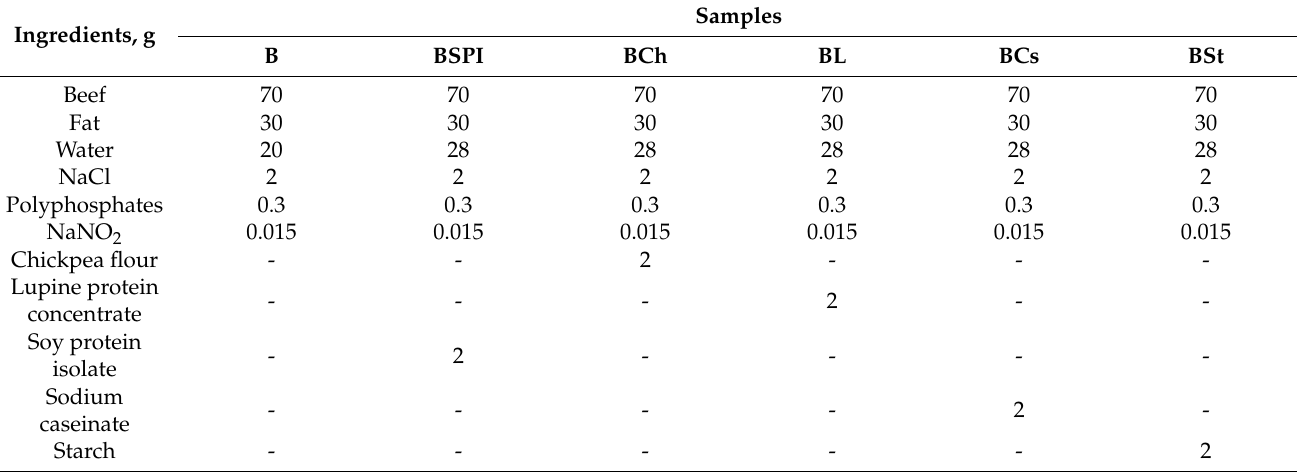
Table 1. Formation of beef emulsions fortified with different protein and amylaceous